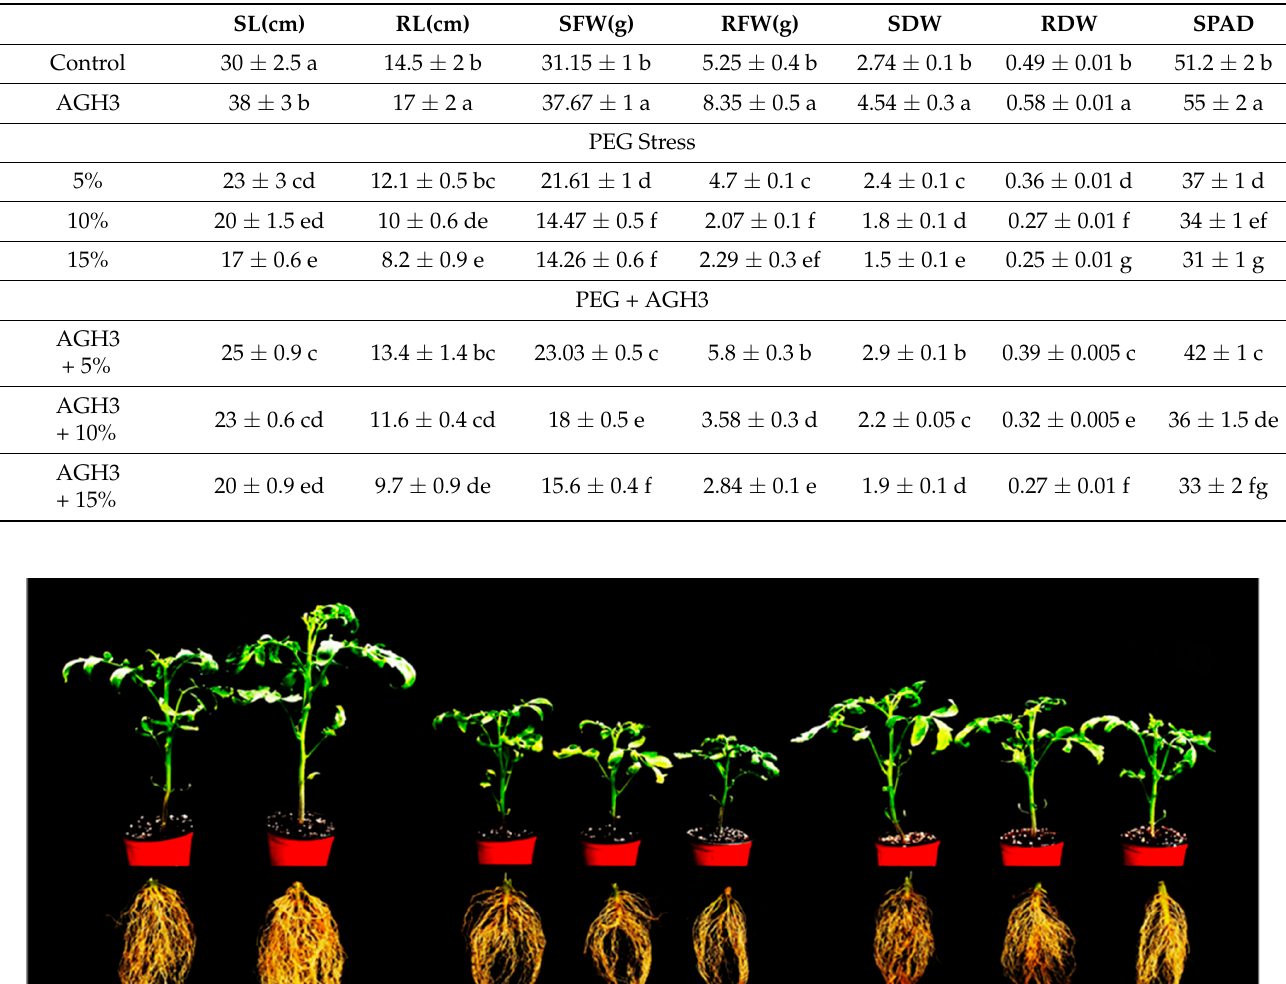
Table 5. Effect of AGH3 on PGP attributes. Different letters in the column show that values are significantly different ( p < 0.05) from each other as evaluated from the DMRT test.